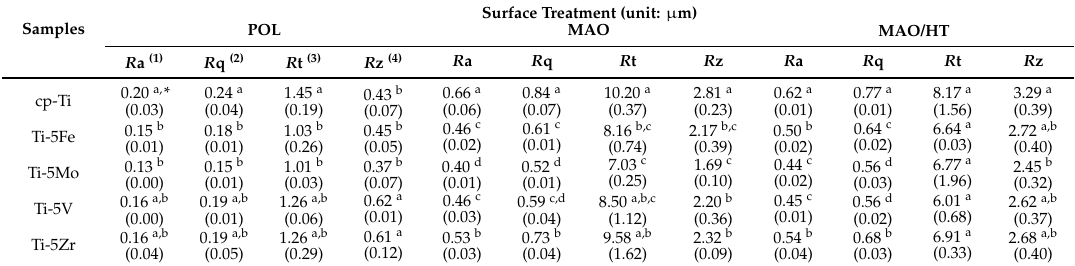
Figure 8. The 3D surface roughness images of POL ‐ , MAO ‐ , and MAO/HT ‐ treated samples. Table 4. Surface roughness parameters obtained from POL-, MAO-, and MAO/HT-treated sample surfaces ( n =